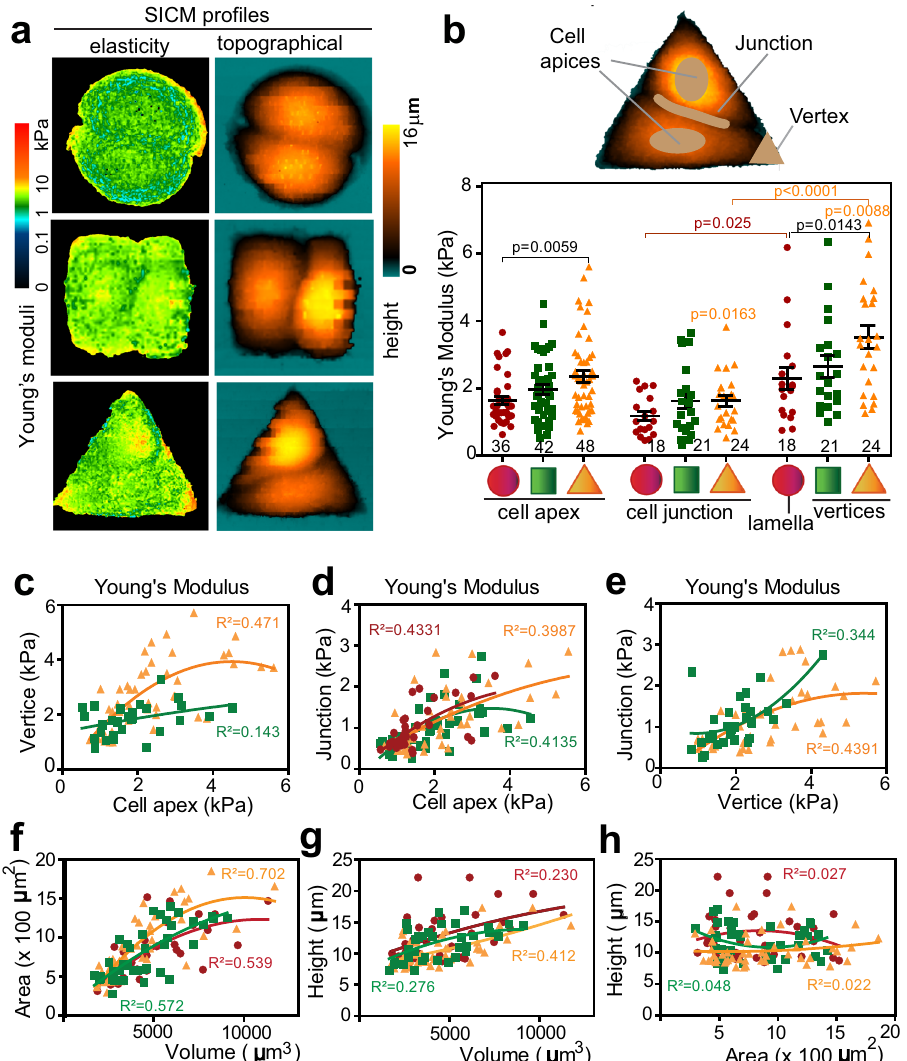
Fig. 2 | Elasticity pro fi les and correlation of biophysical parameters under various geometric constraints. a Cortical elasticity map. Representative SICM imagesofcellpairsshowingelasticity(Young ’ smoduli,left)andtopography(right) maps that were obtained simultaneously. Colour scale bar on the left represents Young ’ smodulusvaluesofthestiffnessmapsfromsofter(darkblue)tostiffer(red). Ontheright,thecolourscalebarshowstheheightfrombaseline(black)tocelltop (yellow). b Diagram shows selected cellular regions of con fi ned cell pairs that had their stiffness measured. Graph shows Young ’ s modulus values plotted per geo- metricshapeand grouped per cellregion. c – e Correlationof stiffnessofindividual cells measured at the cellapex,atvertices ( c )or junction of acellpair( d ).Stiffness measured at vertices or junctions was also correlated ( e ). f – h Individual cell volume, height and area of keratinocytes grown on micropatterns were measured